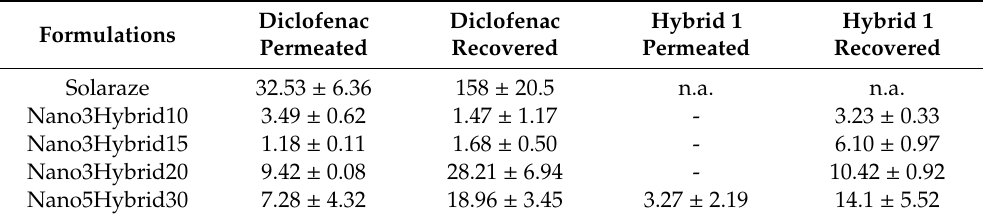
Table 4. Amount of drugs permeated through and recovered into pig ear skin after application of formulations under study (nanomols, mean ± SEM, n = 6).